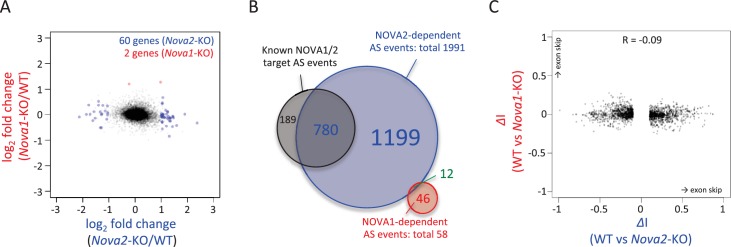
RNA-seq analysis in either Nova2-/- or Nova1-/- versus littermate wild-type control.(A) RNA abundance changes in Nova2-/- and Nova1-/- mice cortex and comparison of its correlation in Nova2-/- with in Nova1-/- mice. X-axis and Y-axis indicated log2(Nova2-KO/wild-type fold change (FC)) and log2(Nova1-KO/wild-type FC), respectively. Transcripts significantly changed in Nova2-/- and Nova1-/- mice cortex were shown in blue and red, respectively (FDR<0.05 and log2|FC|>=1). (B) Summary of NOVA2- and NOVA1-dependent alternative splicing changes that showed |ΔI| >= 0.1 (FDR < 0.1) (Ule et al., 2005b) and that contained YCAY motif(s) within BC2 NOVA1 or NOVA2 HITS-CLIP clusters on alternative splicing exons and/or its upstream/downstream introns. 1991 NOVA2-target alternative splicing events on 540 genes (known [Zhang et al., 2010]; 780 events, novel; 1211 events), 58 NOVA1-target events on 20 genes (known; 0 events, novel 58 events). (C) Correlation of Nova2- and Nova1-deficient impact on alternative splicing events. X-axis and Y-axis indicated ΔI of wild-type (WT) vs Nova2-/- and vs Nova1-/-, respectively.DOI:
http://dx.doi.org/10.7554/eLife.14371.01010.7554/eLife.14371.011Figure 3—source data 1.Gene Ontology (GO) terms associated with NOVA2-target alternative splicing exons.Summary of GO analysis of NOVA2-regulated genes performed using DAVID Bioinformatics Resources (https://david.ncifcrf.gov) (FDR<0.05).DOI:
http://dx.doi.org/10.7554/eLife.14371.01110.7554/eLife.14371.012Figure 3—source data 2.The transcriptome abundance of the neuronal differentiation markers in the E18.5 cortex of Nova1-/- and Nova2-/- mice.log2FC: log2 (Nova1 or Nova2 mutants/wild-type) fold change.